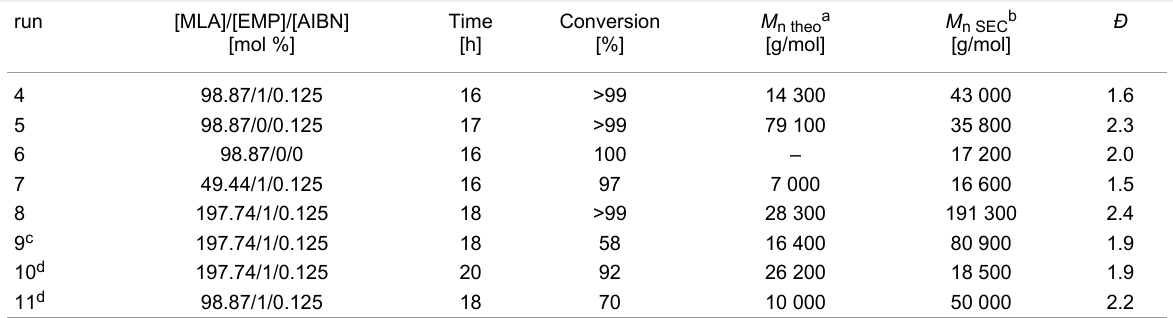
Table 4: RAFT homopolymerization of MLA with EMP (80 wt % 1,4-dioxane at 70 °C). run